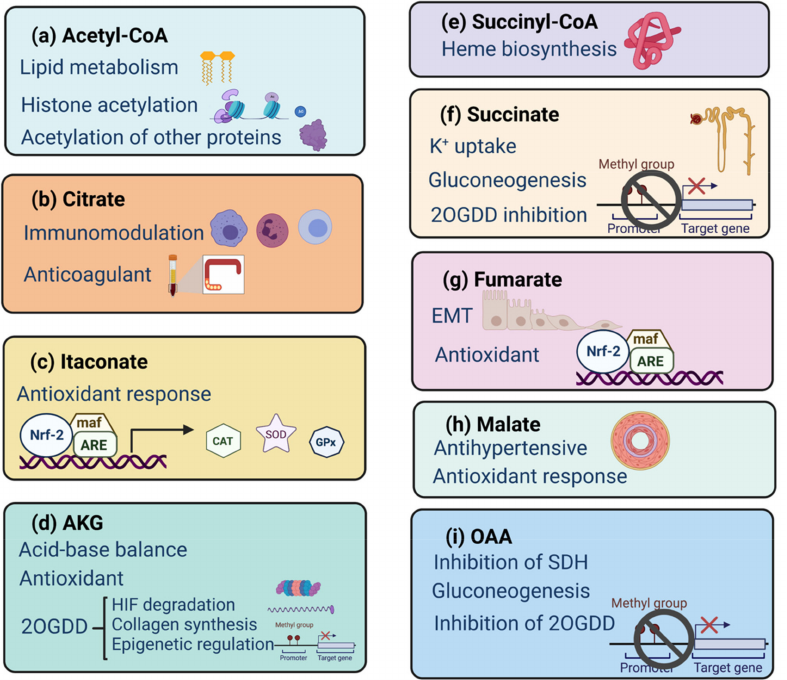
Figure 2. Involvement of TCA cycle metabolites in kidney functions. The metabolites of the TCA cycle and acetyl-CoA participate as signal molecules to promote several critical cellular functions such as epigenetic modifications, redox regulation, hypoxic response, and immunity. Nrf-2: nuclear factor erythroid 2–related factor 2, ARE: antioxidant response element, maf: